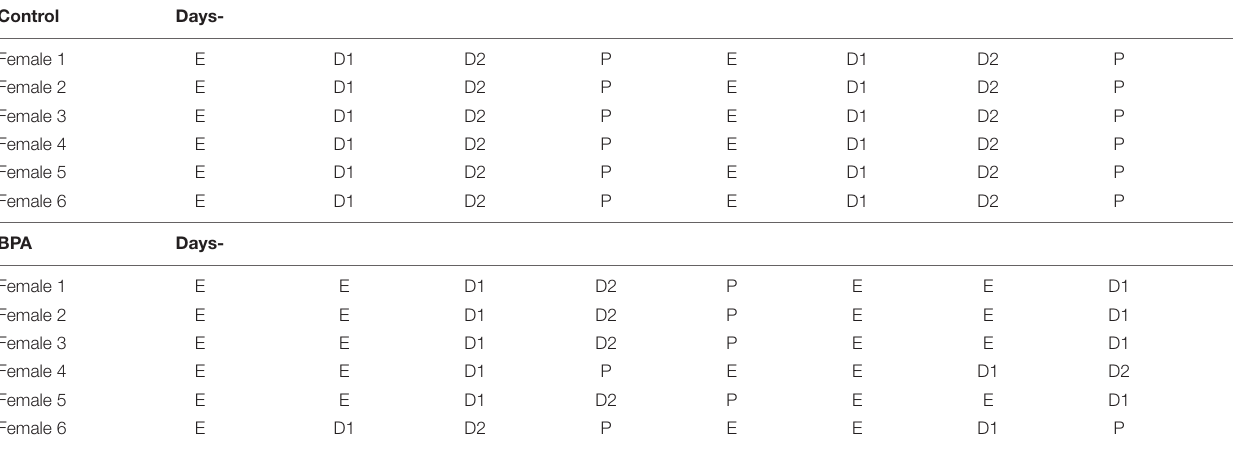
TABLE 1 | Typical estrus cycle of control and BPA-exposed female rats.